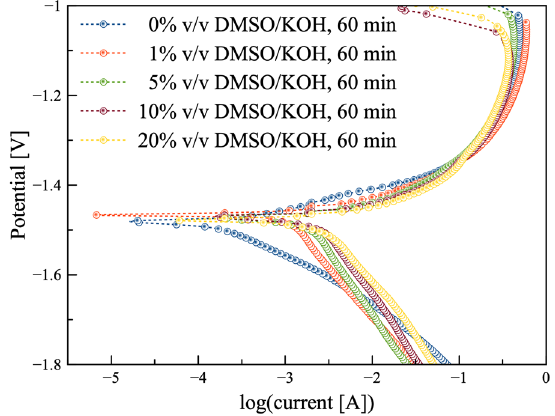
Figure 3. Potentiodynamic polarization measurement of the zinc anode at 60 min after soaking using 0.16 mV/s within the potential range of − 0.3 V to 0.3 V vs. OCV.